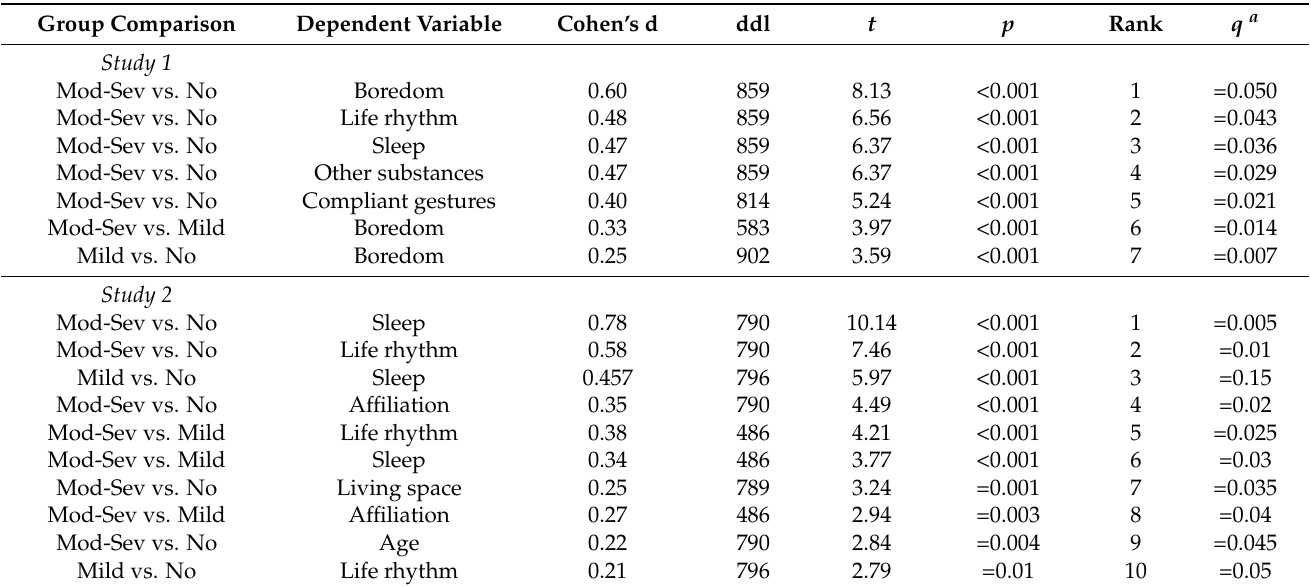
Table 2. Statistical results of comparisons between two groups (moderate-severe vs. mild vs. no-depression). Group